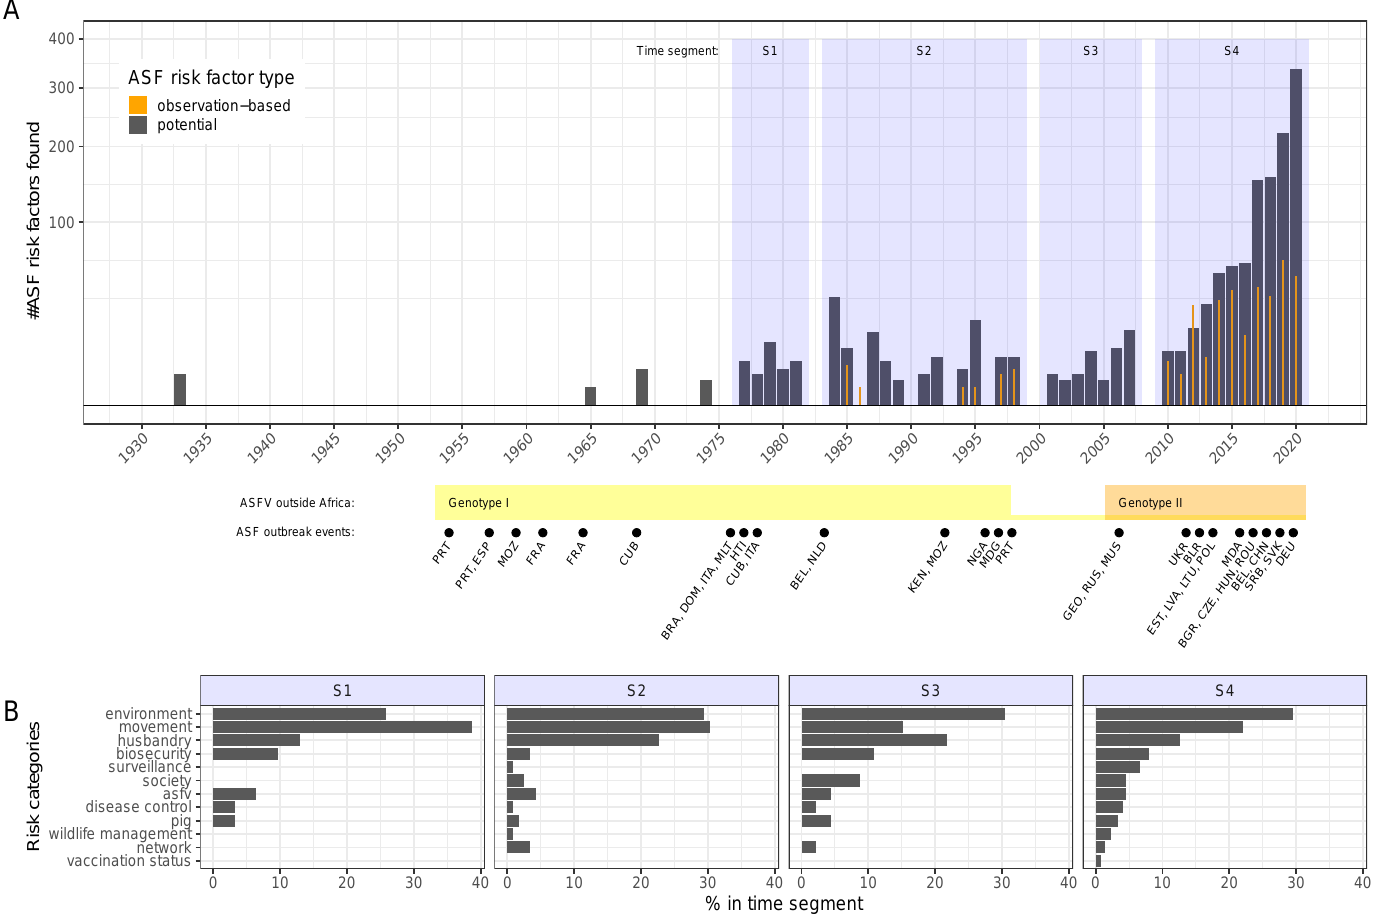
Figure 6. Timeline of potential and observation-based ASF risk factors reported in the literature in relation to time segments of ASF events in the world ( A ). Only ASF genotypes detected outside of Africa are indicated along the time axis. Country names are abbreviated by their ISO 3166 ALPHA-3 code. Categorical distribution of literature-reported potential ASF risk factors in sequential time segments ( B ). Time segments are: S1: 1977–1981, S2: 1984–1998, S3: 2001–2007, S4: 2010–2021. ASFV, African swine fever